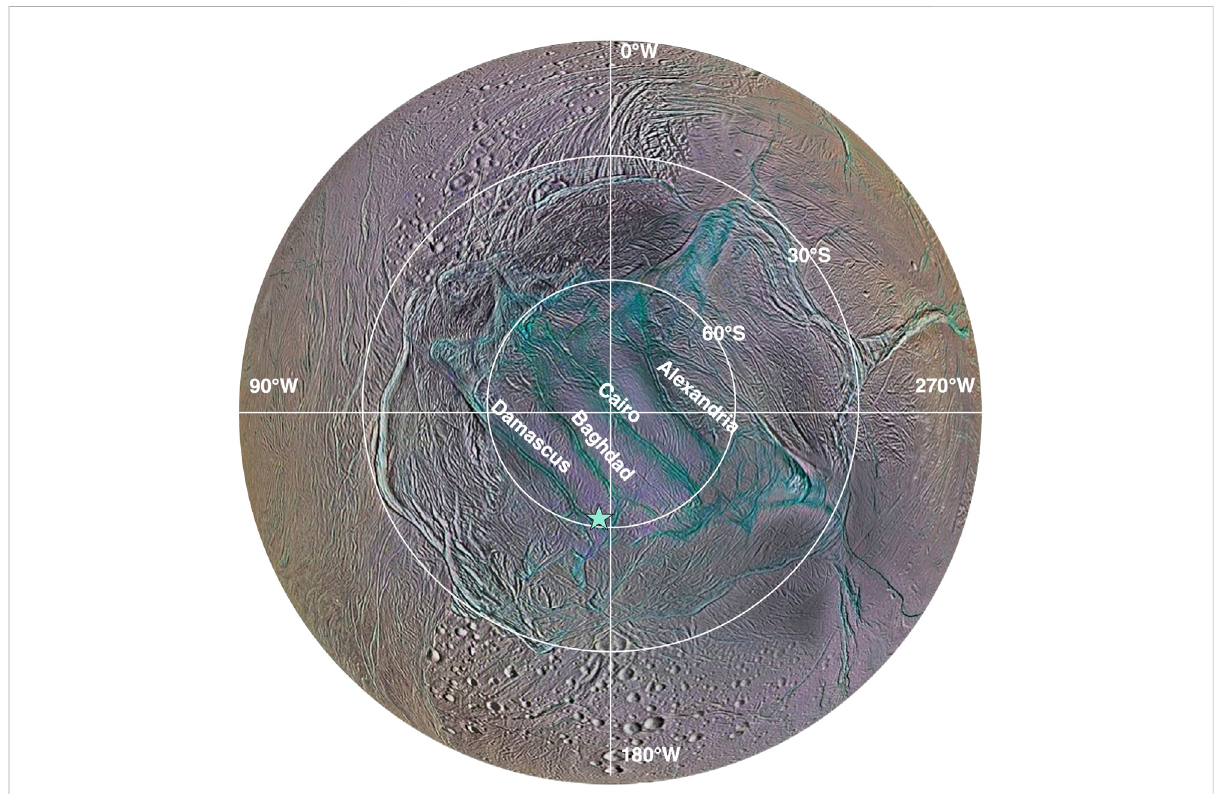
FIGURE 3 Nominal landing site marked by teal star, at the junction of Baghdad. The four southern Tiger Stripes are labeled for reference. Backmap is a mosaic (pixel resolution of 100 m) constructed from Cassini ISS images in polar stereographic projection (Credit: Paul Schenk,